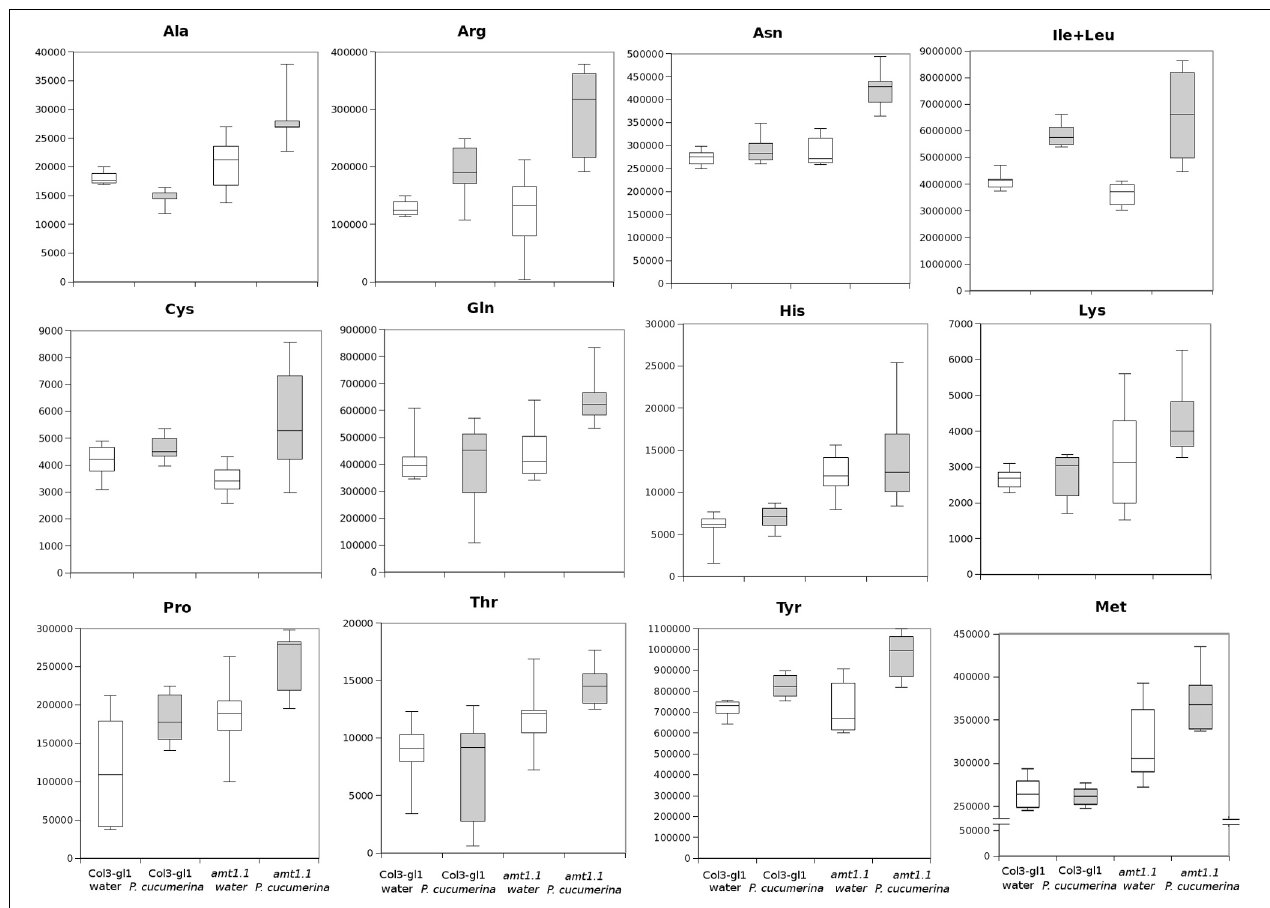
FIGURE 7 | Aminoacid profiling upon P. cucumerina infection. Two week old Col3-gl/1 and amt1.1 plants either mock or P. cucumerina inoculated were processed for relative quantification analysis by HPLC-QTOFMS data. The concentration of the metabolites was determined in all the samples by normalizing the chromatographic area for each compound with the dry